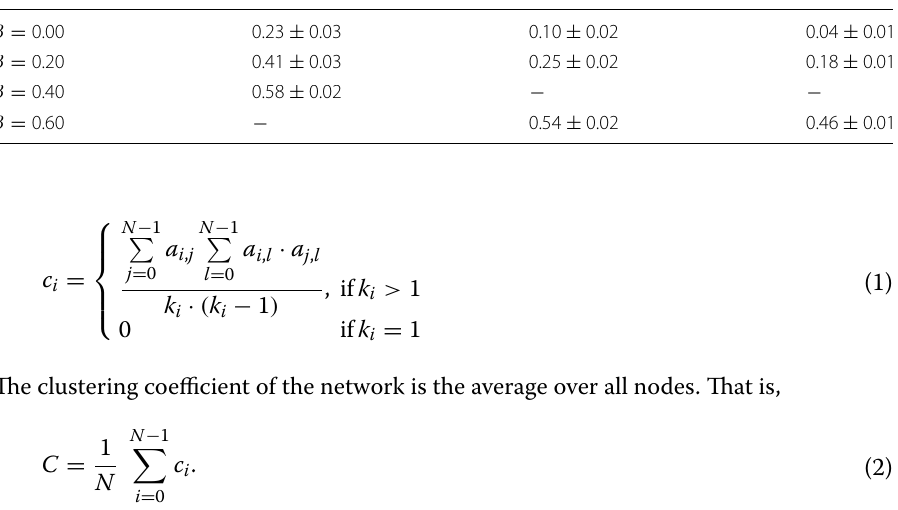
Table 1 Clustering coefficient for networks generated by different combination of γ and β . For each (γ , β) , the clustering coefficient is the average over 100 generated networks γ = 2.25 γ = 2.50 γ = 3.00 β =